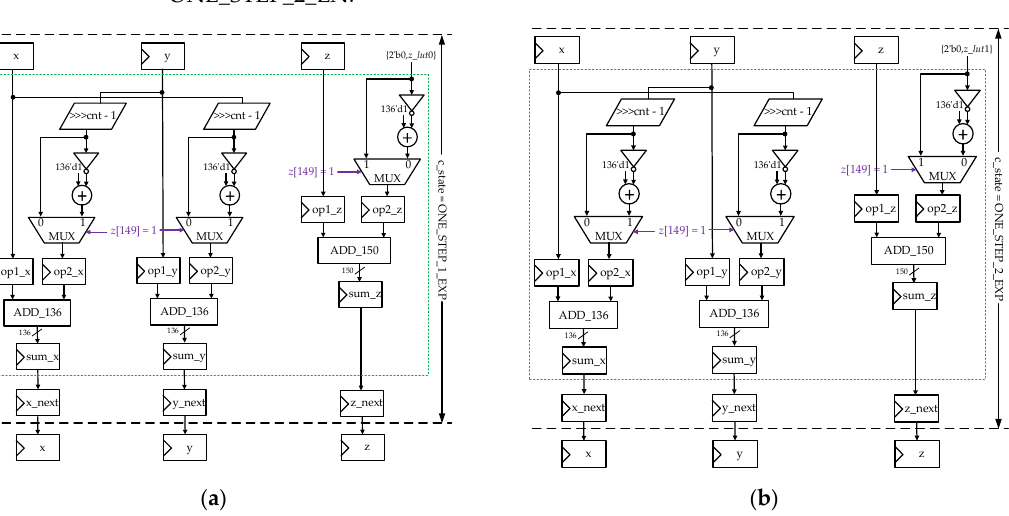
Figure 11. ( a ) Architecture of the state ONE_STEP_1_EXP; ( b ) architecture of the state Figure 11. ONE_STEP_2_EXP.